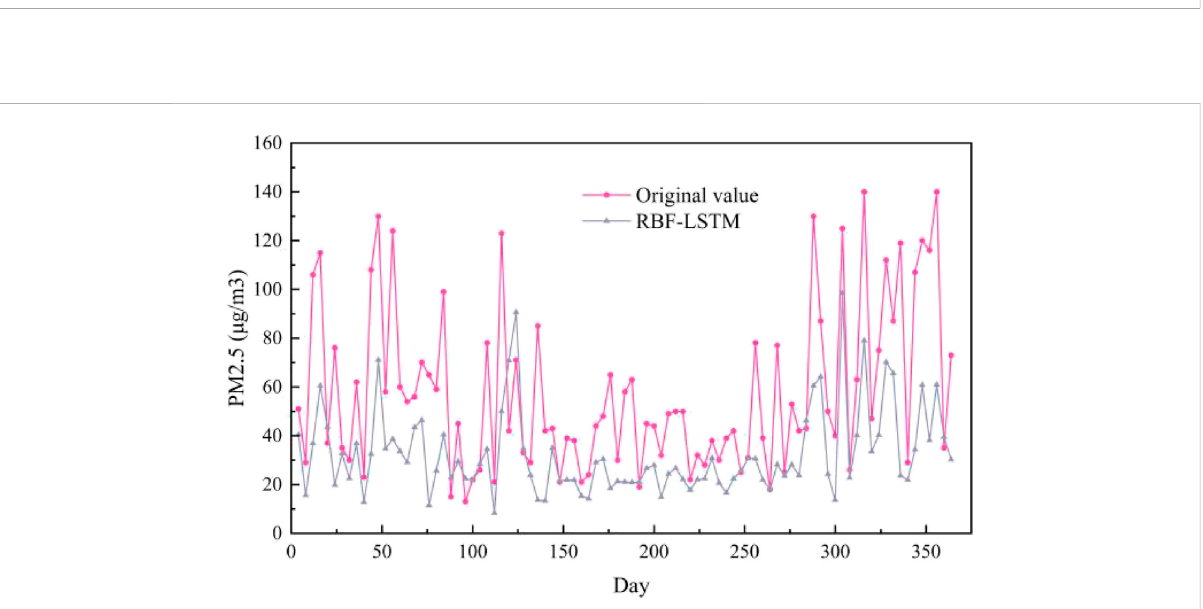
FIGURE 11 Experimental results of IDW-LSTM method in Baoding test set.